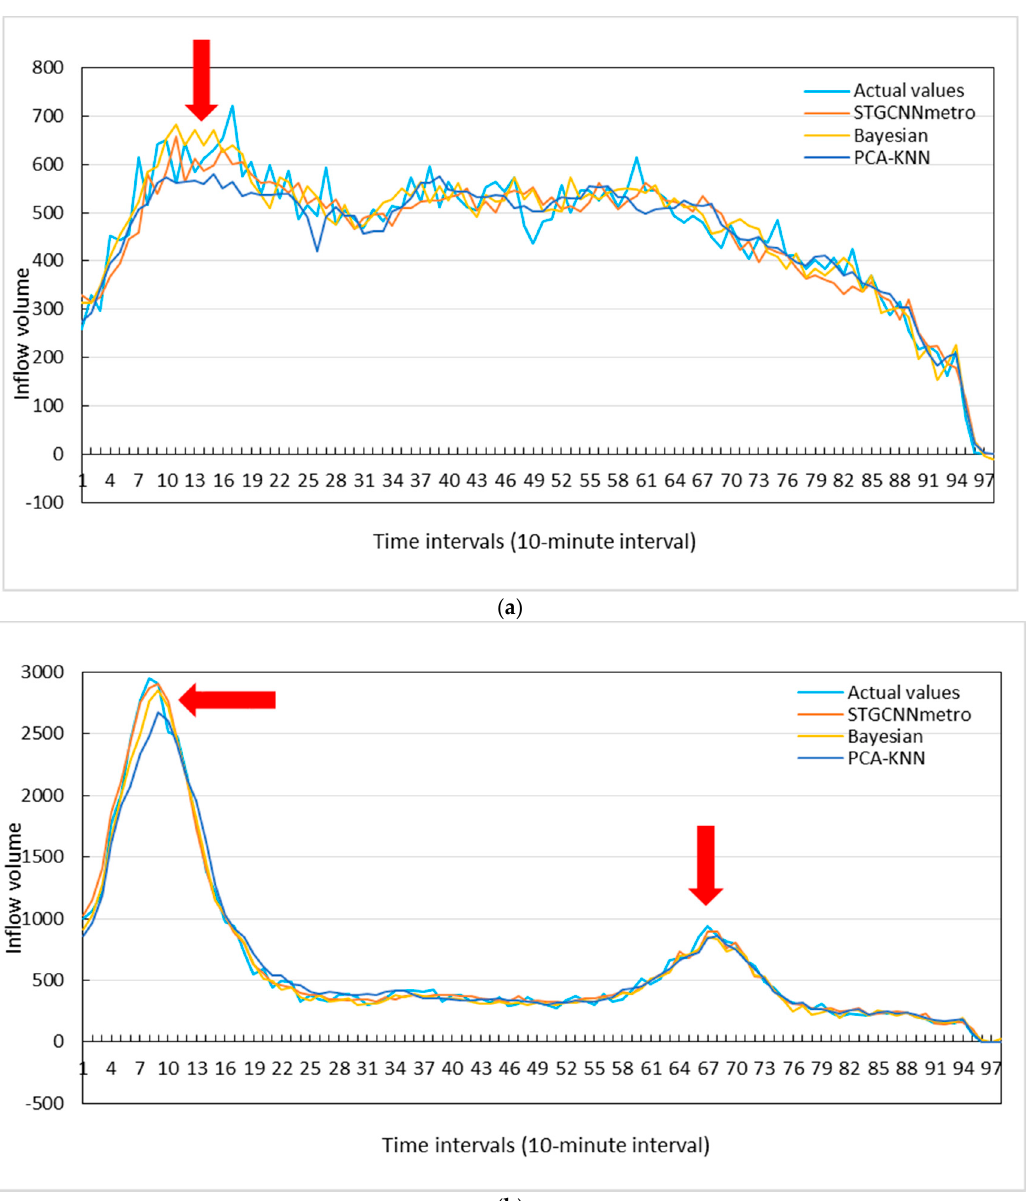
Figure 8. A comparison of the predicted and actual values of passenger inflow volume between 6:40 a.m. and 11:00 p.m. at the Shenzhuang metro station for ( a ) a Sunday (non-working day) and ( b ) a Monday (working day).